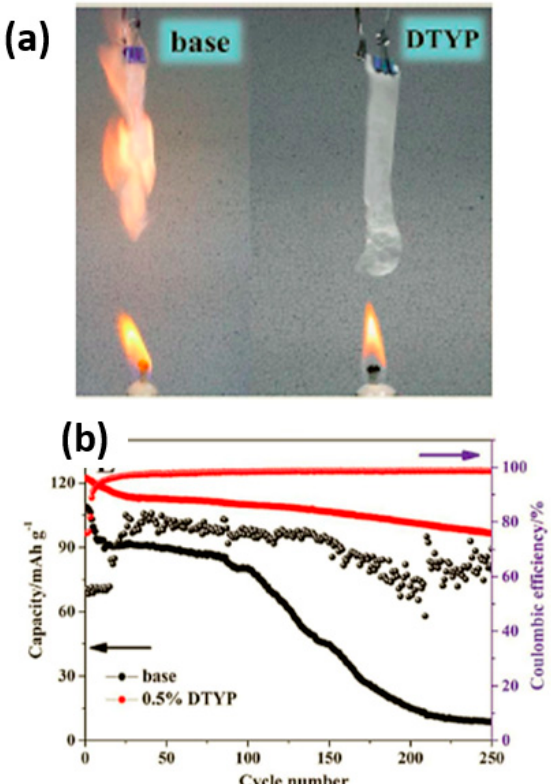
Figure 18. ( a ) Flammability tests of the PE membrane with base and DTYP-containing electrolytes. ( b ) The cycling performance of the batteries with the base and DTYP-containing electrolytes [58]. Reprinted with permission, © 2018.